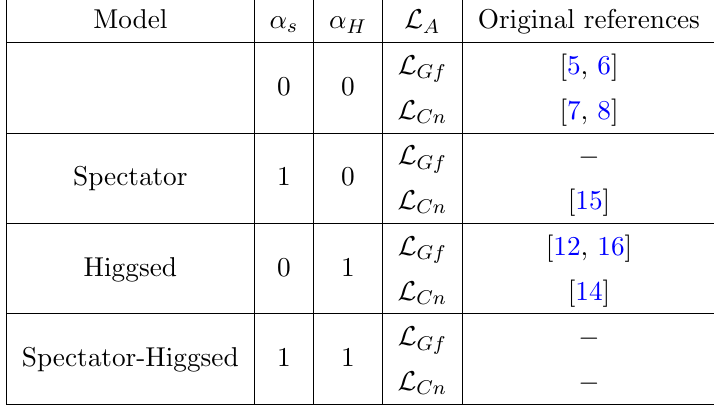
Table 1 . In(cid:13)ationary models involving an SU(2) gauge (cid:12)eld in the literature and their relation to L A , (cid:11) s and (cid:11) H